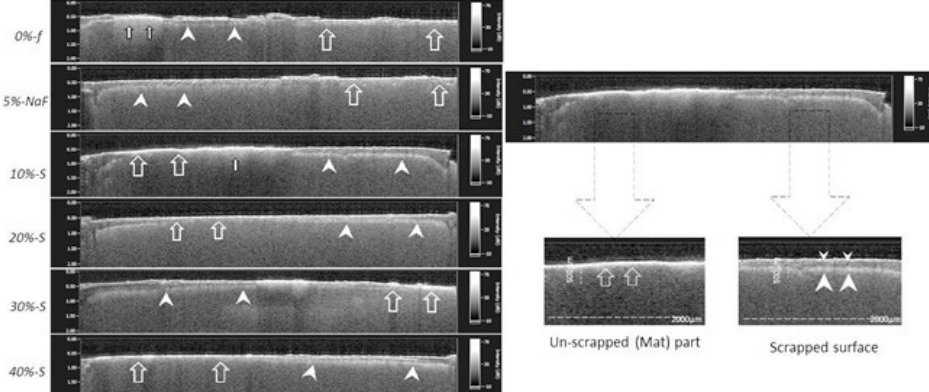
Figure 4. SS ‐ OCT images displaying demineralization depths ( μ m) beneath DV layers; both un ‐ scraped (Mat) part (large arrows) and scraped (removed) part (arrowheads) of each specimen. Clear difference can be seen between unscraped part and scraped part; mineral loss appeared to be less in unscraped part for experimental groups, while dentin became almost transparent in craped part, indicating remarkable mineral loss for all groups. Demineralization depths were more than 140 μ m on average for all materials.